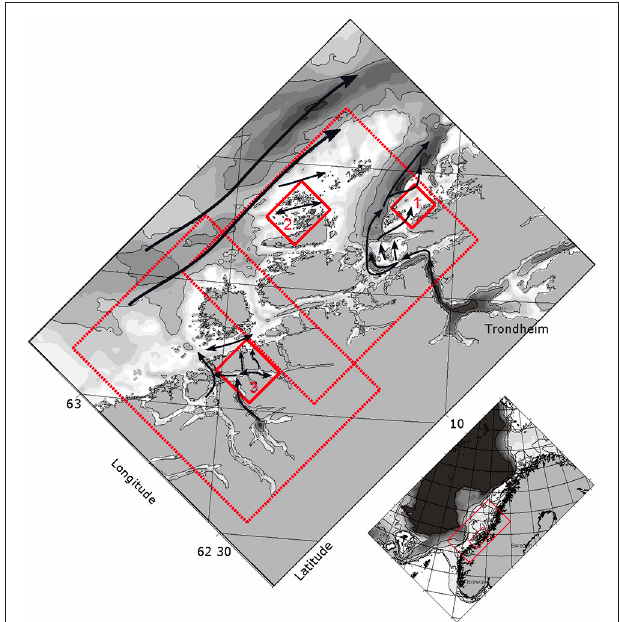
FIGURE 2 | Overview of the study areas in the coastal region of central Norway and the SINMOD model domains used to generate water current fields for the DREAM simulations. Excerpt from the 800m resolution model domain (indicated by solid red lines in the small panel) with 160m (dashed red lines) and 32m (solid red lines) model domains indicated. The three locations used in this study are location 1 (Tristeinen, red T, 63.87 ◦ N, 9.62 ◦ E), location 2 (Rataren, two cage arrays, red R, at 63.781 ◦ N, 8.517 ◦ E, and 63.783 ◦ N, 8.523 ◦ E) and location 3 (Korsneset, red K, 63.143 ◦ N, 8.225 ◦ E). The coordinates refer to the location of the middle of the cage arrays at the time when the MOM surveys were carried out.